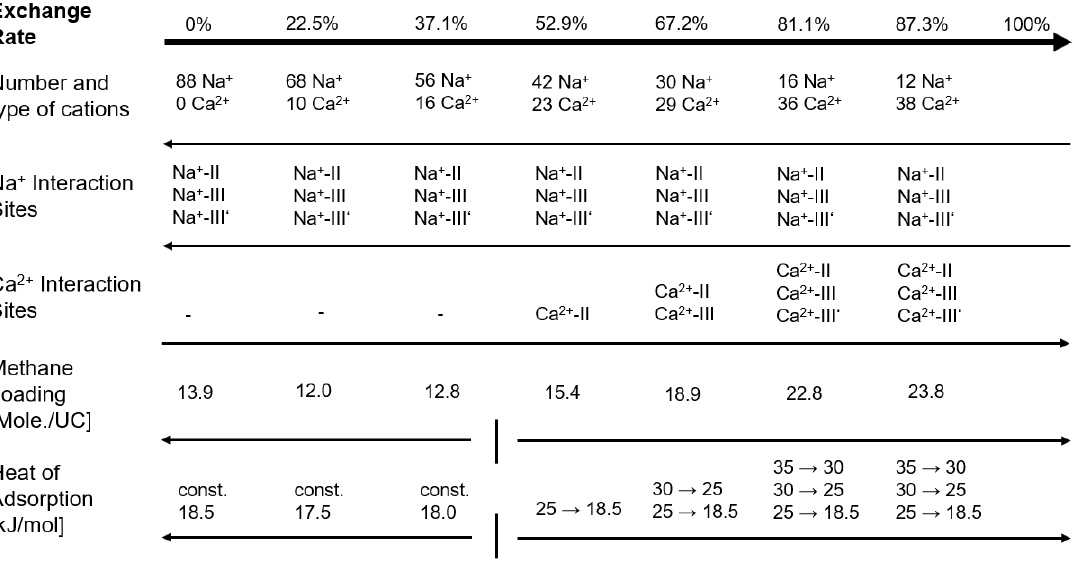
Figure 3. Graphical compilation of results.